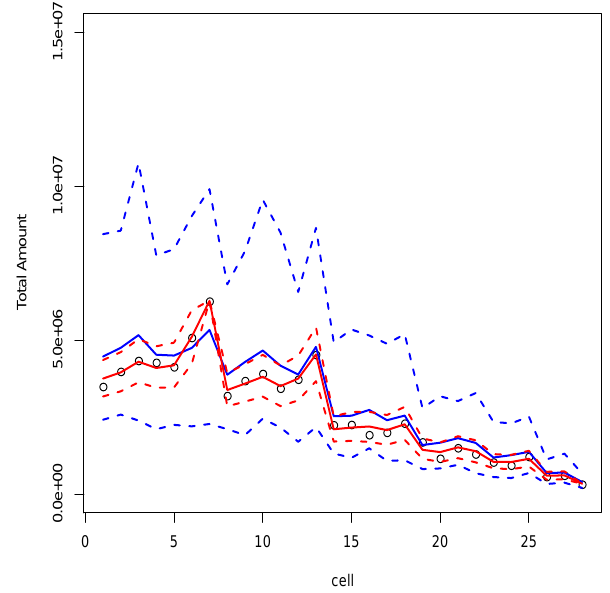
Figure 3. Observed data (circles) with conditional predictions ( red lines) and unconditional ones ( blue lines) from Model G with θ = 10.